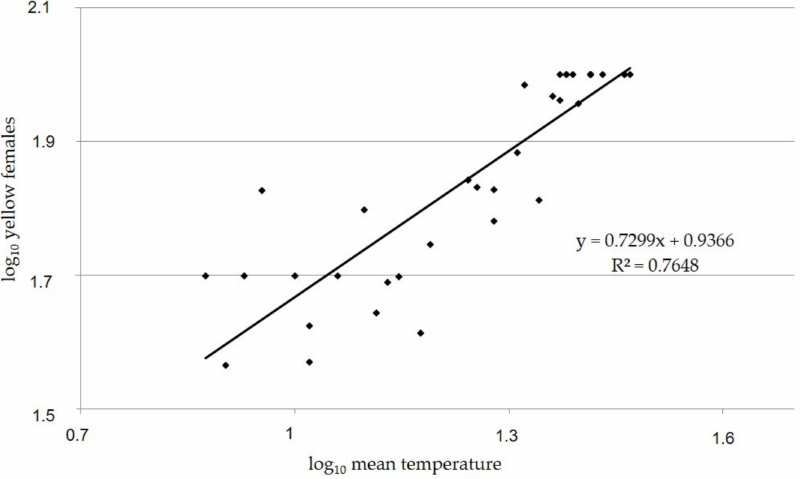
Figure 4. Linear regression between number of yellow females of Cirrospilus pictus and log of mean temperature ( ◦ C) (SIAS) detected in the surveyed field of Citrus spp. in Sicily (Italy) from January 2000 to December 2003.